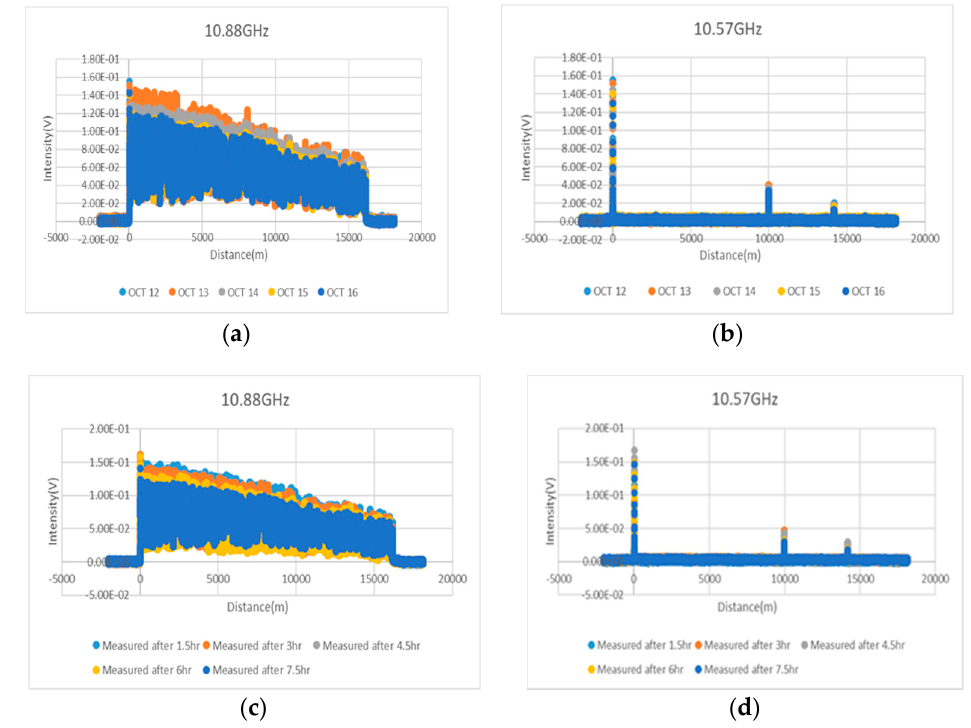
Figure 5. ( a ) The optical intensity against fiber distance data in BOTDA at 10.88 GHz, ( b ) the optical intensity against fiber distance data in BOTDA at 10.57 GHz addressing the reproducibility issue, ( c ) the optical intensity against fiber distance data in BOTDA at 10.88 GHz, ( d ) the optical intensity against fiber distance data in BOTDA at 10.57 GHz addressing the repeatability issue.